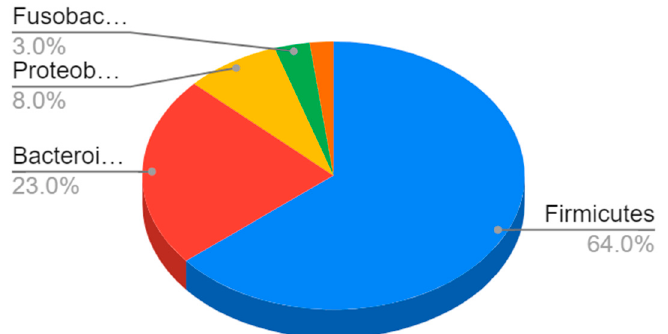
Figure 1. Composition of the gut microbiota. The most represented phyla are Firmicutes (64%) and Bacteroidetes (23%), followed by Proteobacteria (8%), Fusobacteria, verrucomicrobia, and actinobac- teria (3%).